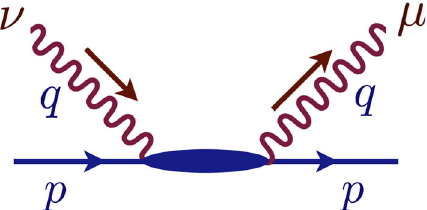
Fig. 7 Forward VVCS